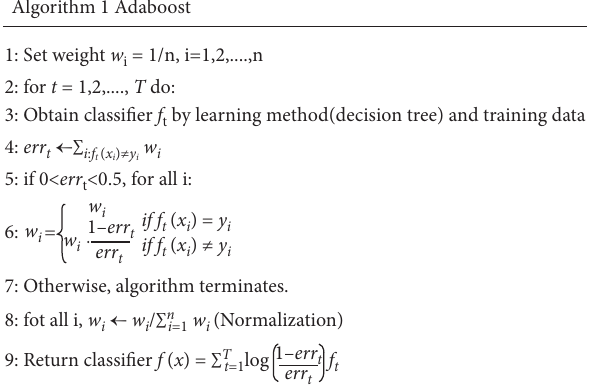
Figure 6: AdaBoost algorithm.